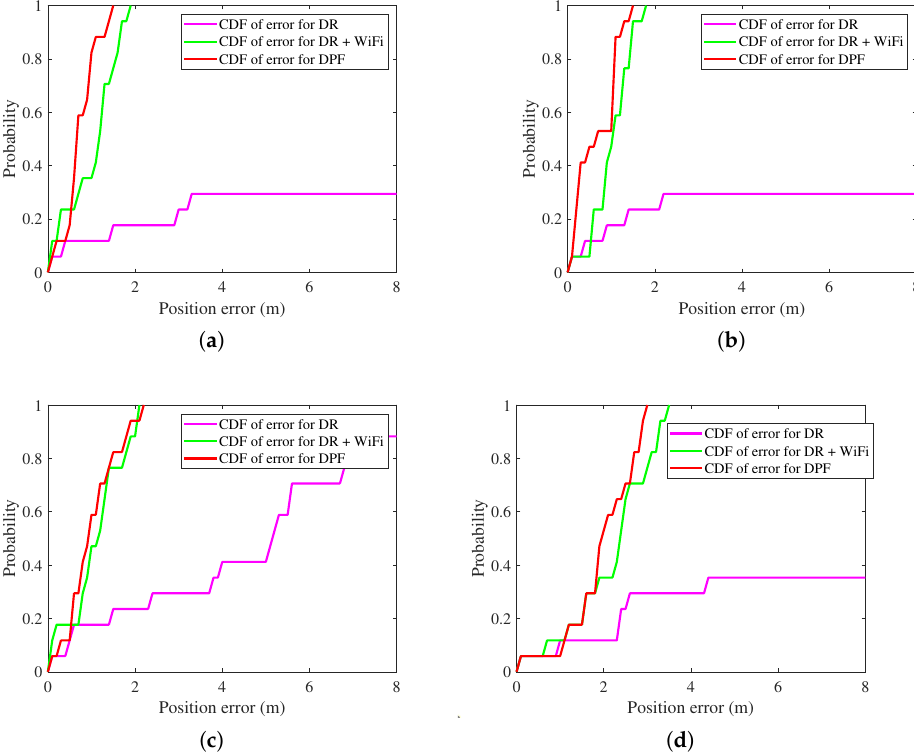
Figure 9. CDFs of errors with different modes. ( a ) CDFs of errors with calling mode. ( b ) CDFs of errors with dangling mode. ( c ) CDFs of errors with handheld mode. ( d ) CDFs of errors with pocketed